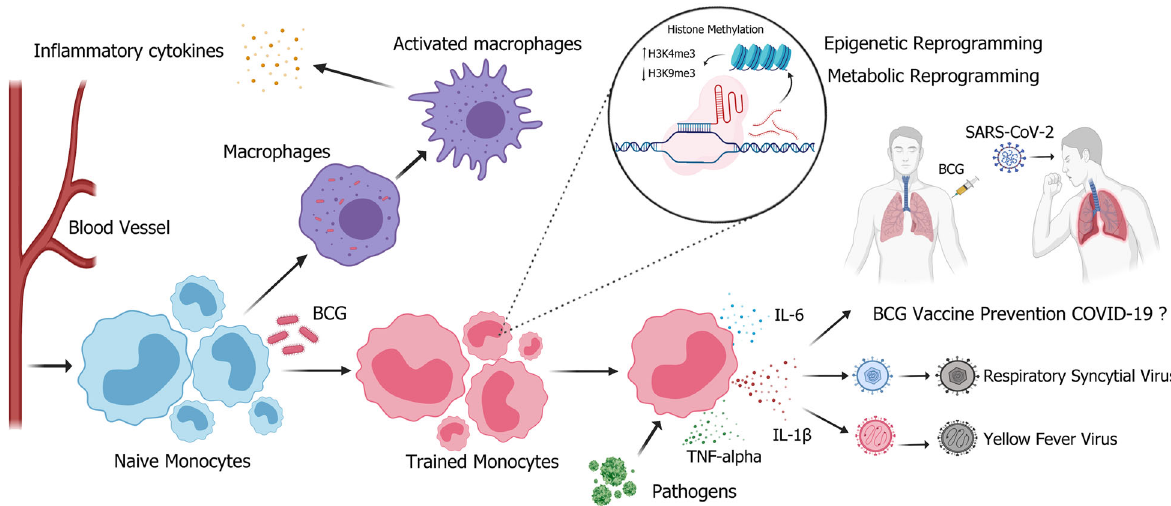
Fig. 2 BCG vaccination induces trained immunity. BCG vaccination induces trained immunity of monocytes/macrophages, leading to increased epigenetic reprogramming and host defense capabilities. Chromatin rearrangement induces a “ trained ” state in monocytes, hence enhancing the effectiveness of innate immune response upon exposure to non-speci fi c pathogens (respiratory syncytial virus or yellow fever virus), and inducing the secretion of proin fl ammatory cytokines, such as IL-6, IL-1 β , and TNF-alpha. However, whether this “ training process ” can prevent severe acute respiratory syndrome coronavirus 2 (SARS-CoV-2) needs further validation. H3K4me3: trimethylation of lysine at position 4 on histone 3; H3K9me3: trimethylation of lysine at position 9 on histone 3. Figure was created using